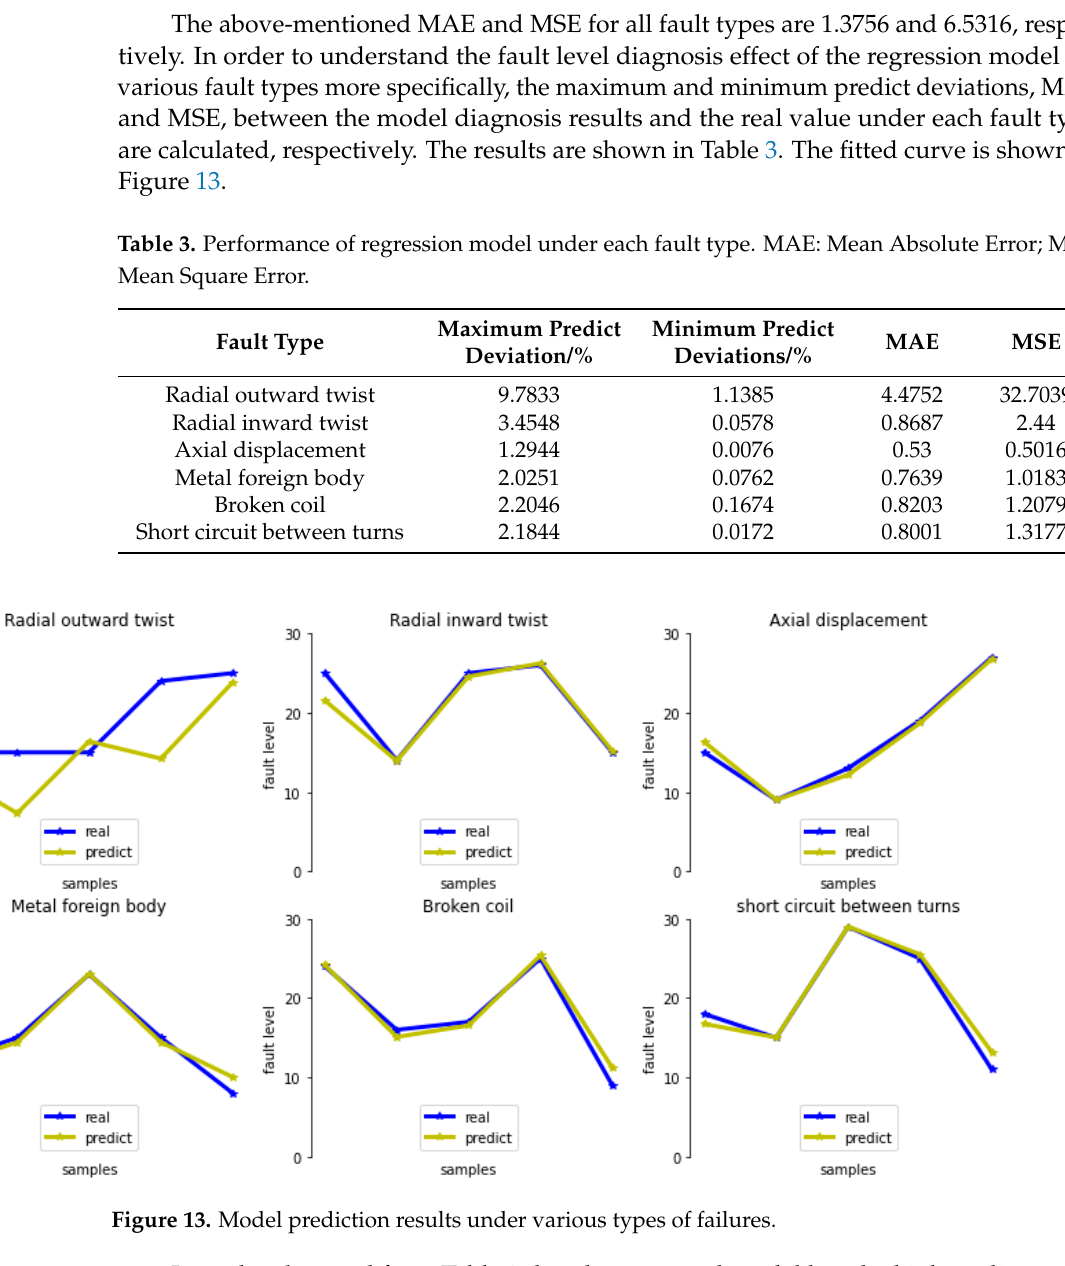
Figure 12. Performance of the model on validation set.